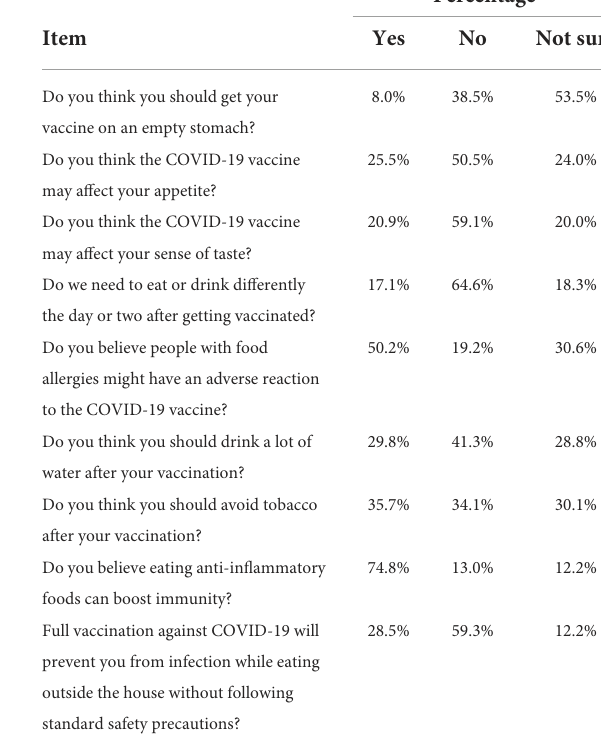
TABLE 2 Jordanian university students’ opinions on the COVID-19 vaccine ( n =